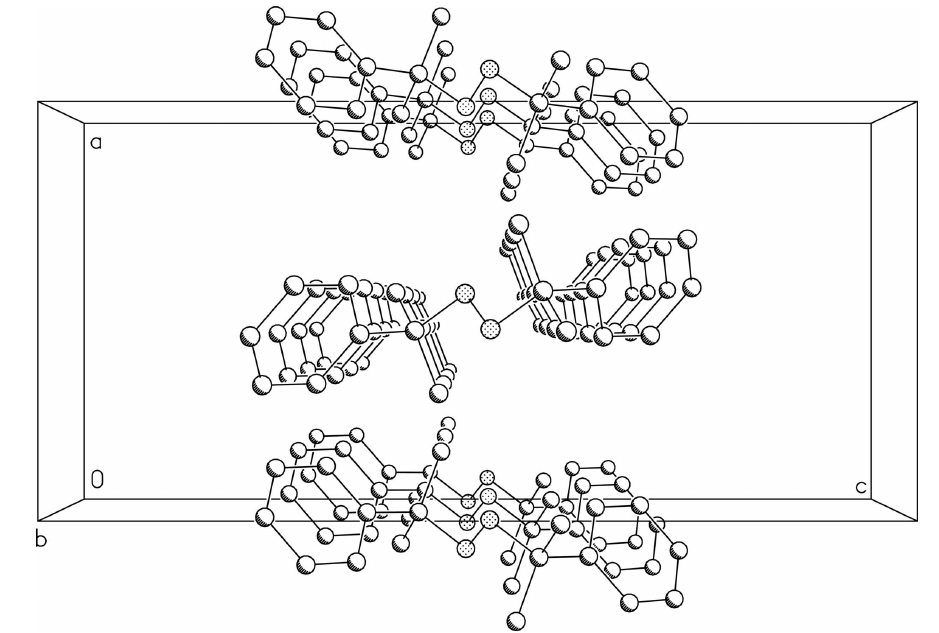
Figure 2 The packing diagram of (I), viewed down the b axis. H atoms have been